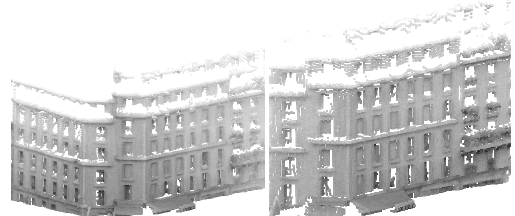
Figure 4: MMS dataset colored using ambient occlusion: two acquisitions of the same area, but with a temporal shift.